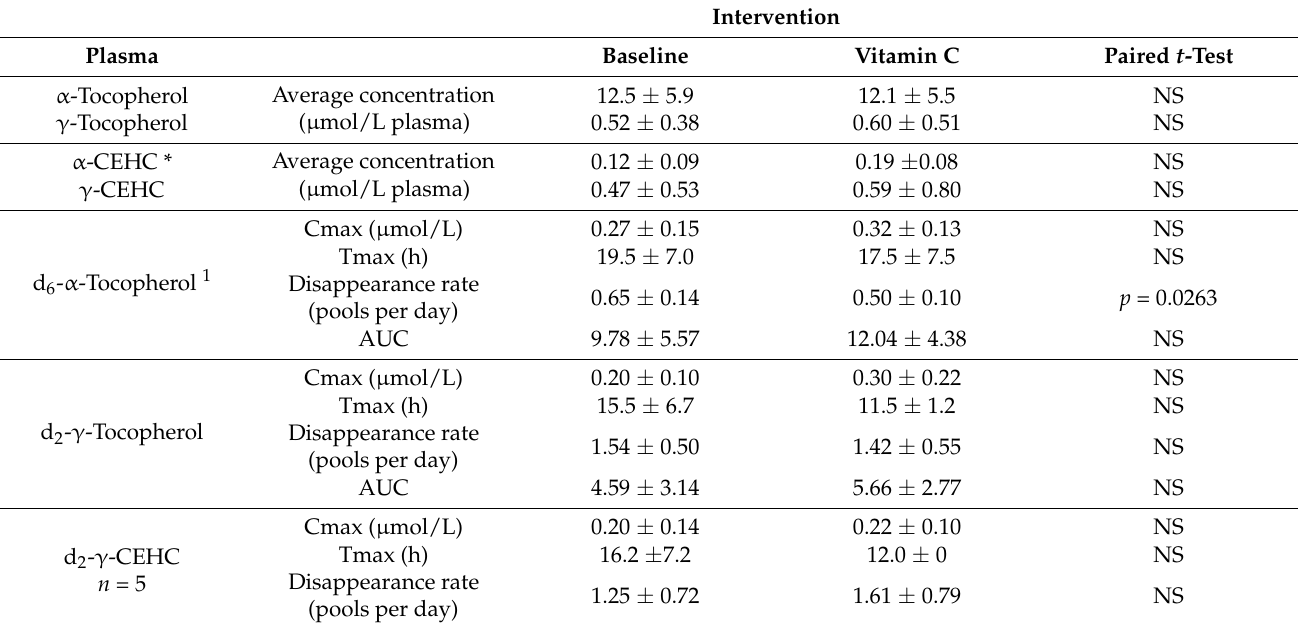
Table 3. The vitamin E concentrations and pharmacokinetic parameters.